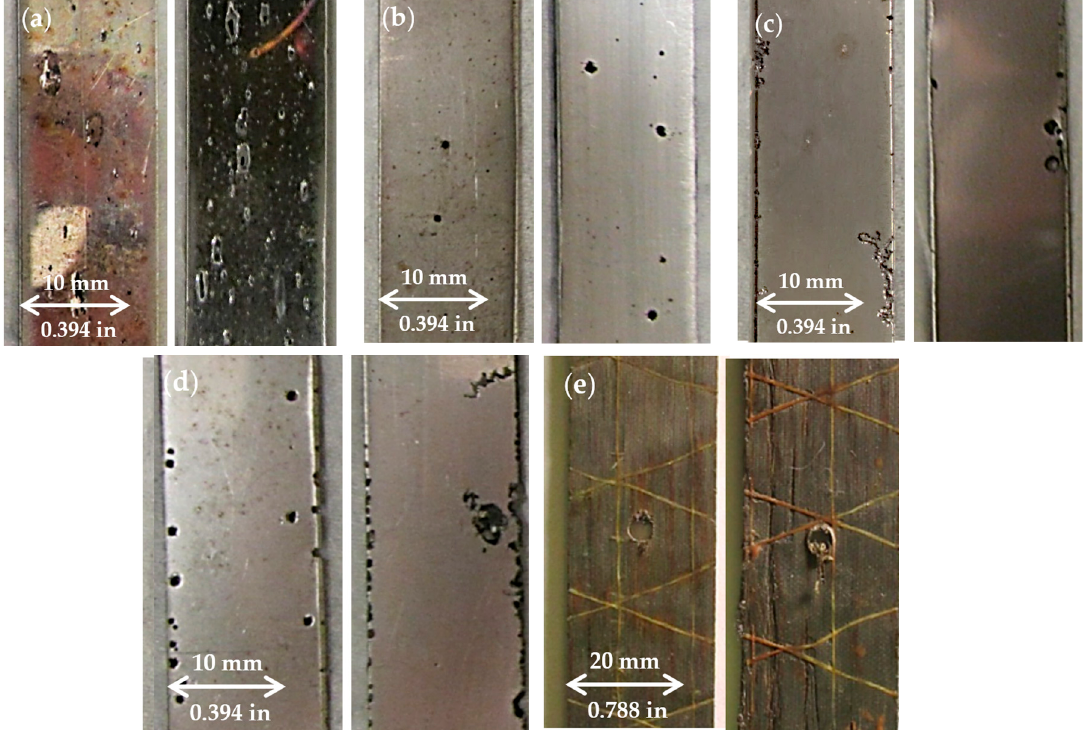
Figure 6. Examples of pitting shape and frequency for ( a ) Type 430, ( b ) Type 17 ‐ 4, ( c ) Type 316, ( d ) Type 304, and ( e ) steel composite samples.